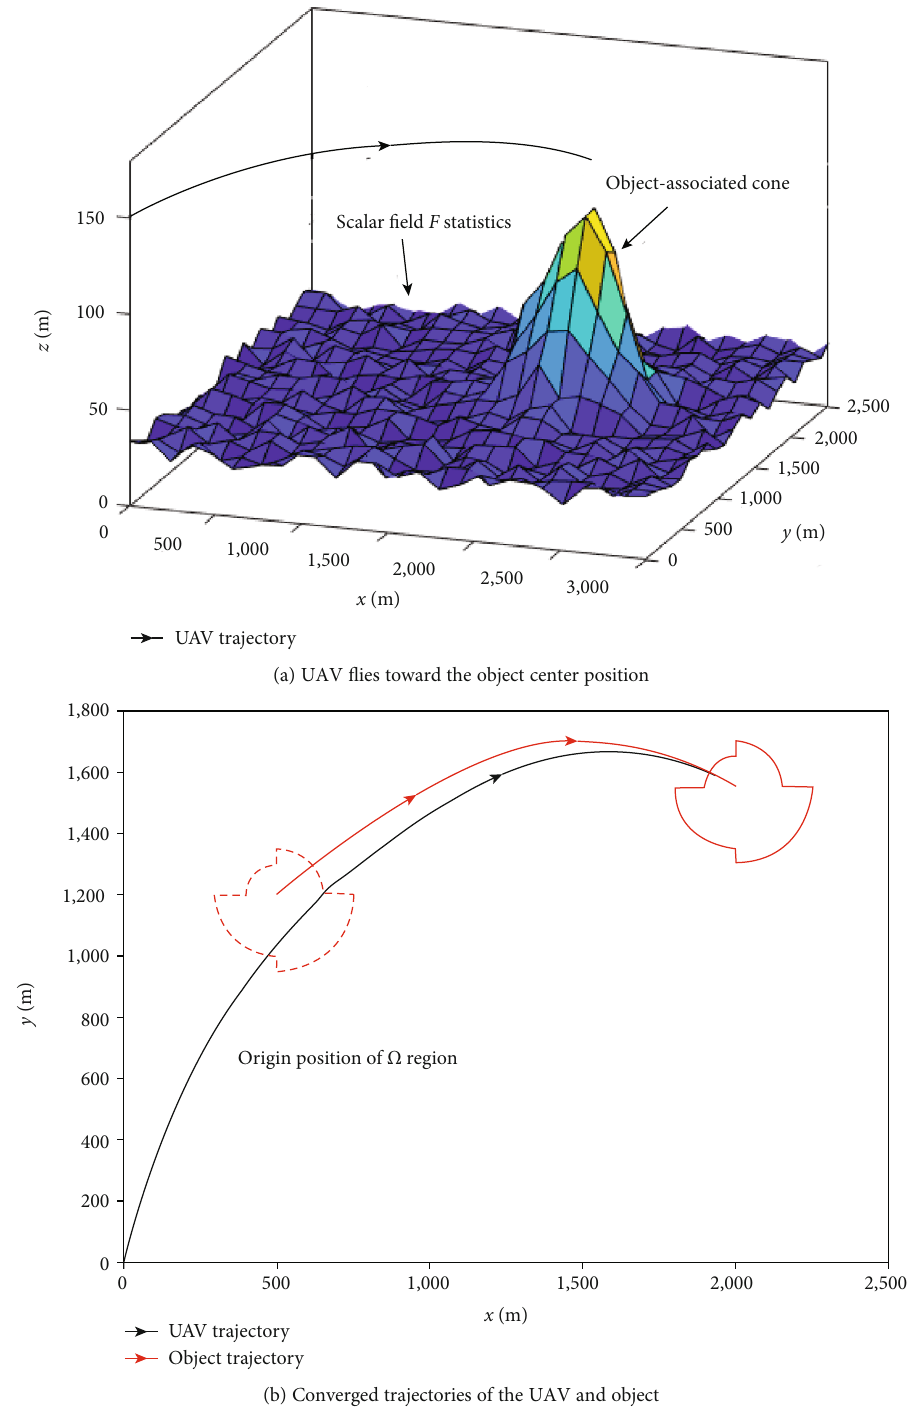
Figure 8: Movement of the UAV toward the moving target object. Gradient calculation in conjunction with “ wait-in-front ” self-navigation strategy helped the UAV catch the target after a relatively short time of